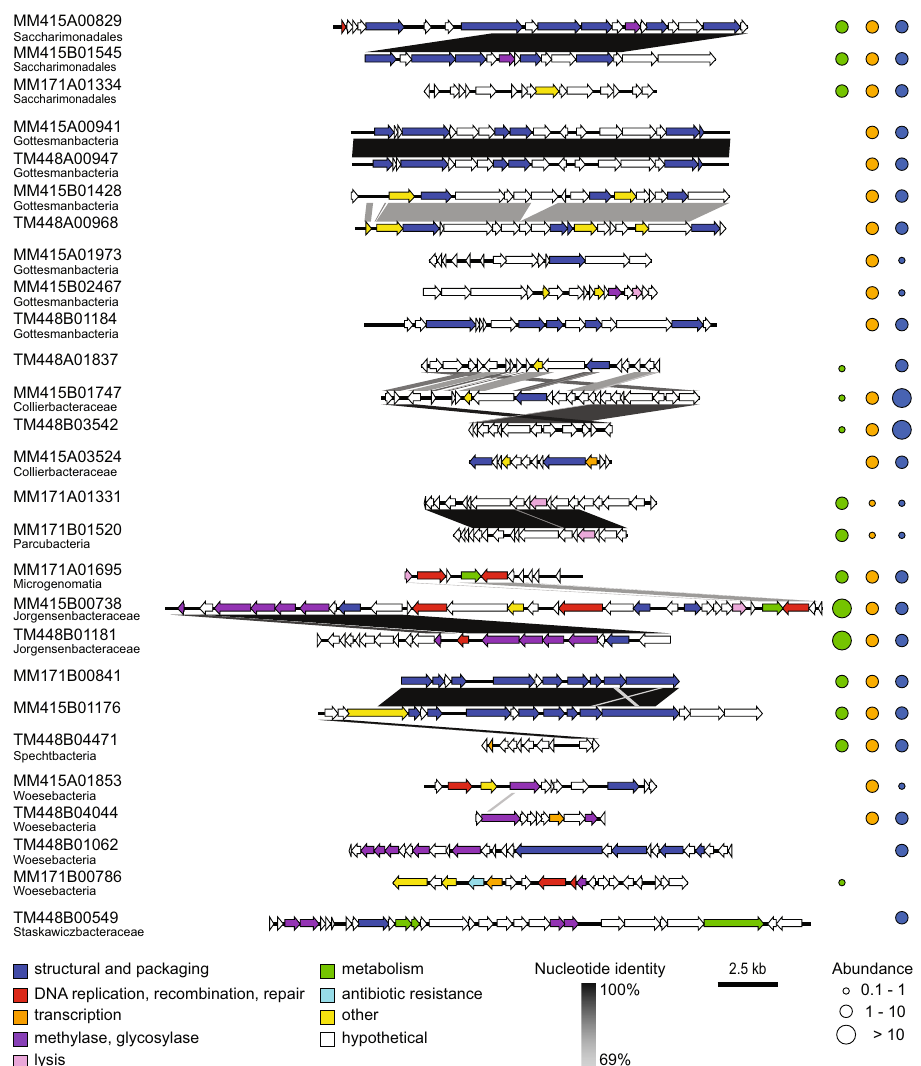
Fig. 6 Annotation of viral contigs potentially infecting Patescibacteria and their relative abundance within the Äspö HRL groundwaters. Selected viral contigs suggested by k-mer analysis to infect Patescibacteria where lower taxonomic ranks could be determined as well as contigs similar to those in the three Äspö HRL groundwaters. Functional annotation of the predicted genes is given by color coding, nucleotide identity between contigs is given by the heat scale, the scale bar represents contig length, and abundance is given as mean base pair read depth normalized for the metagenome size in the MM- 171.3 (green), MM-415.2 (orange), and TM-448.2